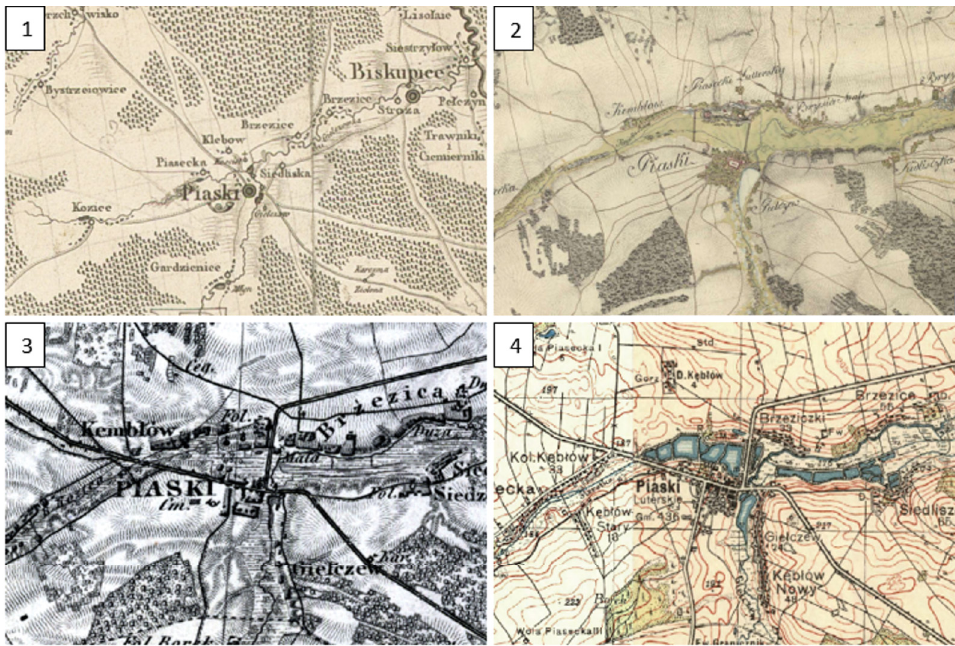
Fig. 2. The road network around Piaski: 1 – a part of the Special Map of the Lublin Voivodship of C. Perthées (1:225,000, 1786), 2 – a part of the Heldensfeld’s Map of Western Galicia (1:28,800, 1801–1804), 3 – a part of the Quartermaster’s Map (1:126,000, 1843), 4 – a part of the MGI Tactical Map (1:100,000, 1938) (the author’s own